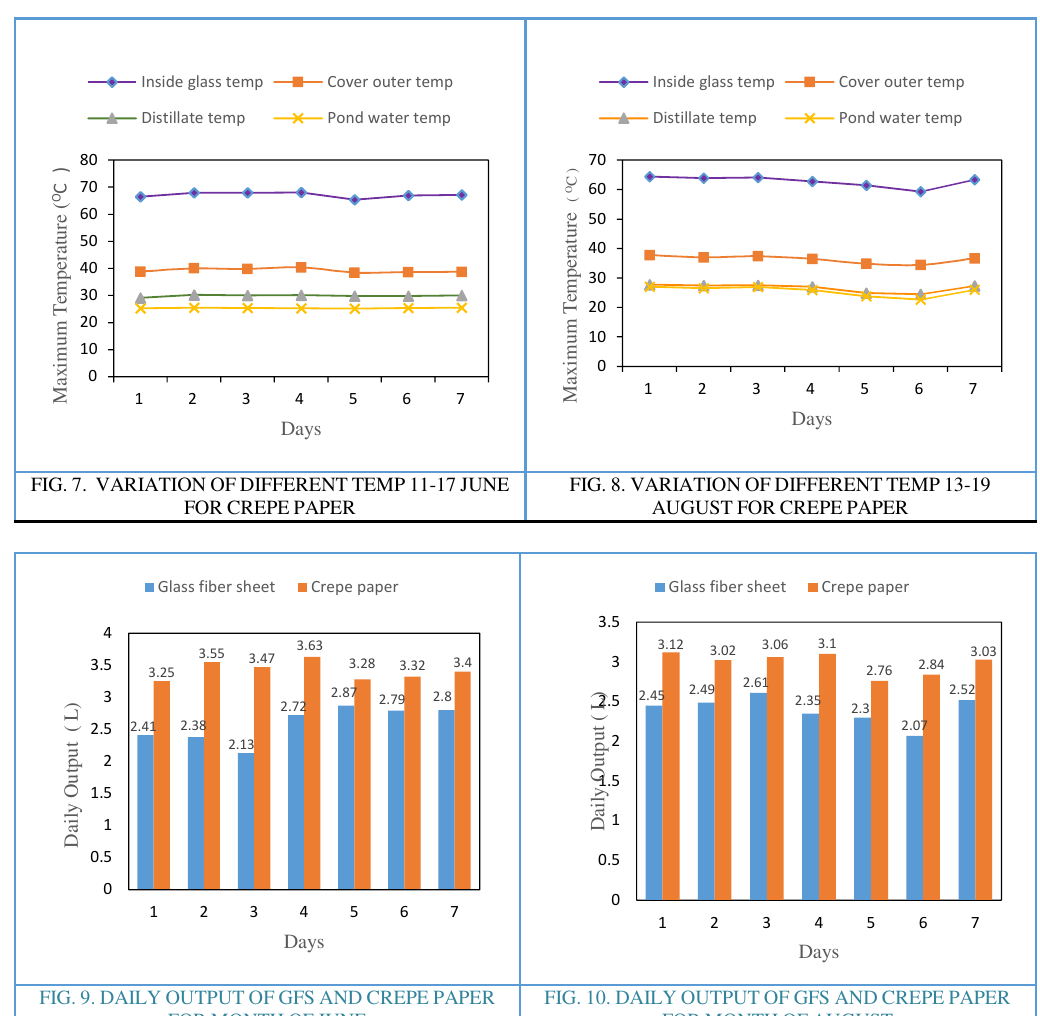
FIG. 9. DAILY OUTPUT OF GFS AND CREPE PAPER FOR MONTH OF JUNE